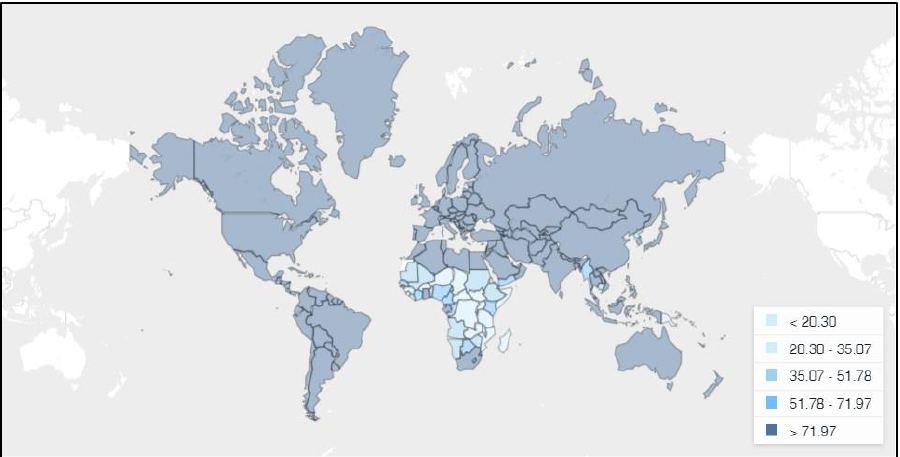
Figure 1. Access to electricity (% of population) World Bank, Sustainable Energy for All (SE4ALL) database from the SE4ALL Global Tracking Framework led jointly by the World Bank [11].